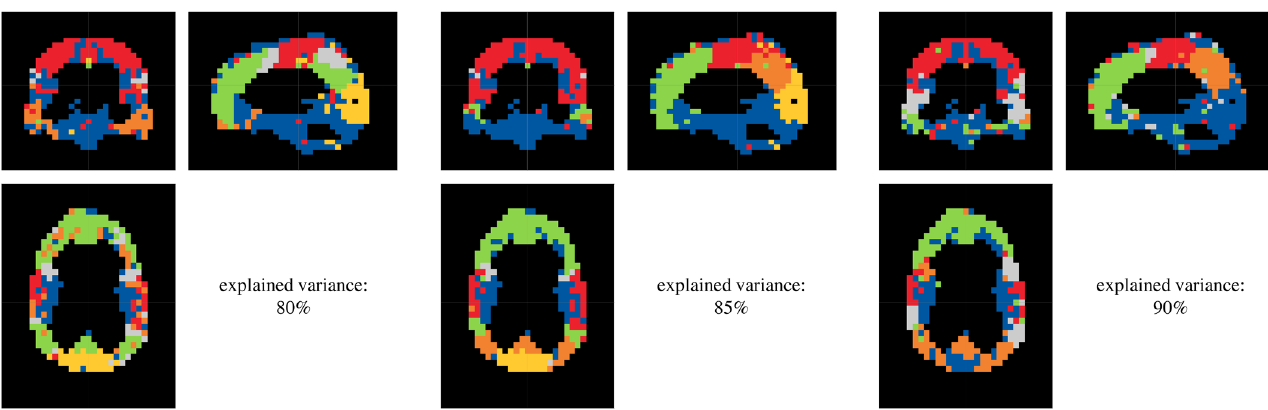
Fig 9. Results of the resting state fMRI functional segmentation for different variance explanations (subject E, 95% edge weight distribution percentile, “ Louvain ” directed). Each color represents one identified module.